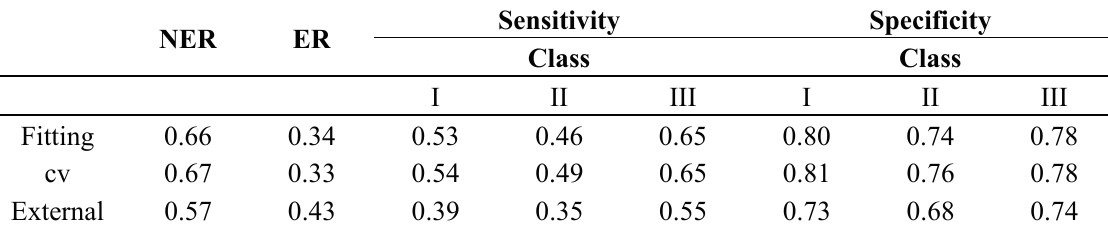
Table 4. Classification parameters of k -NN classification